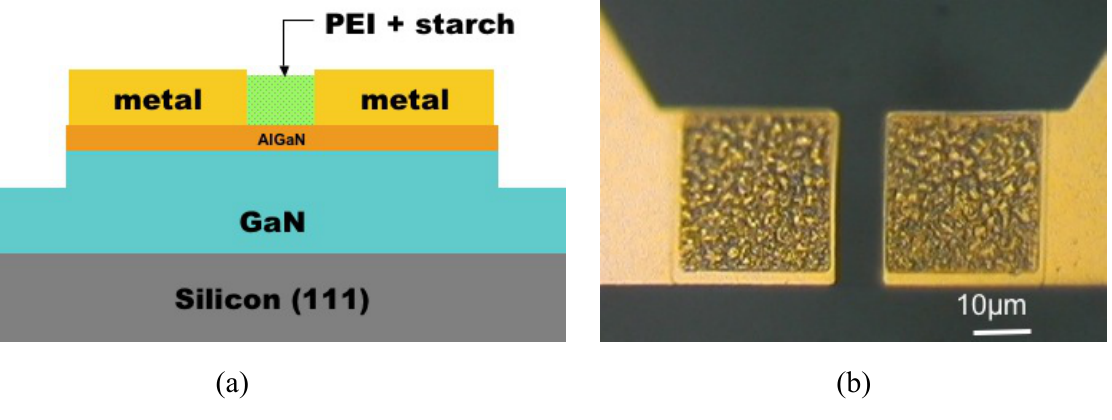
sensor (b) plan view 2 2